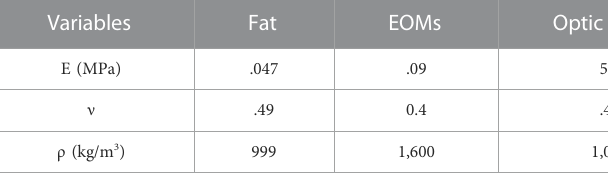
TABLE 2 Material properties of fi nite element